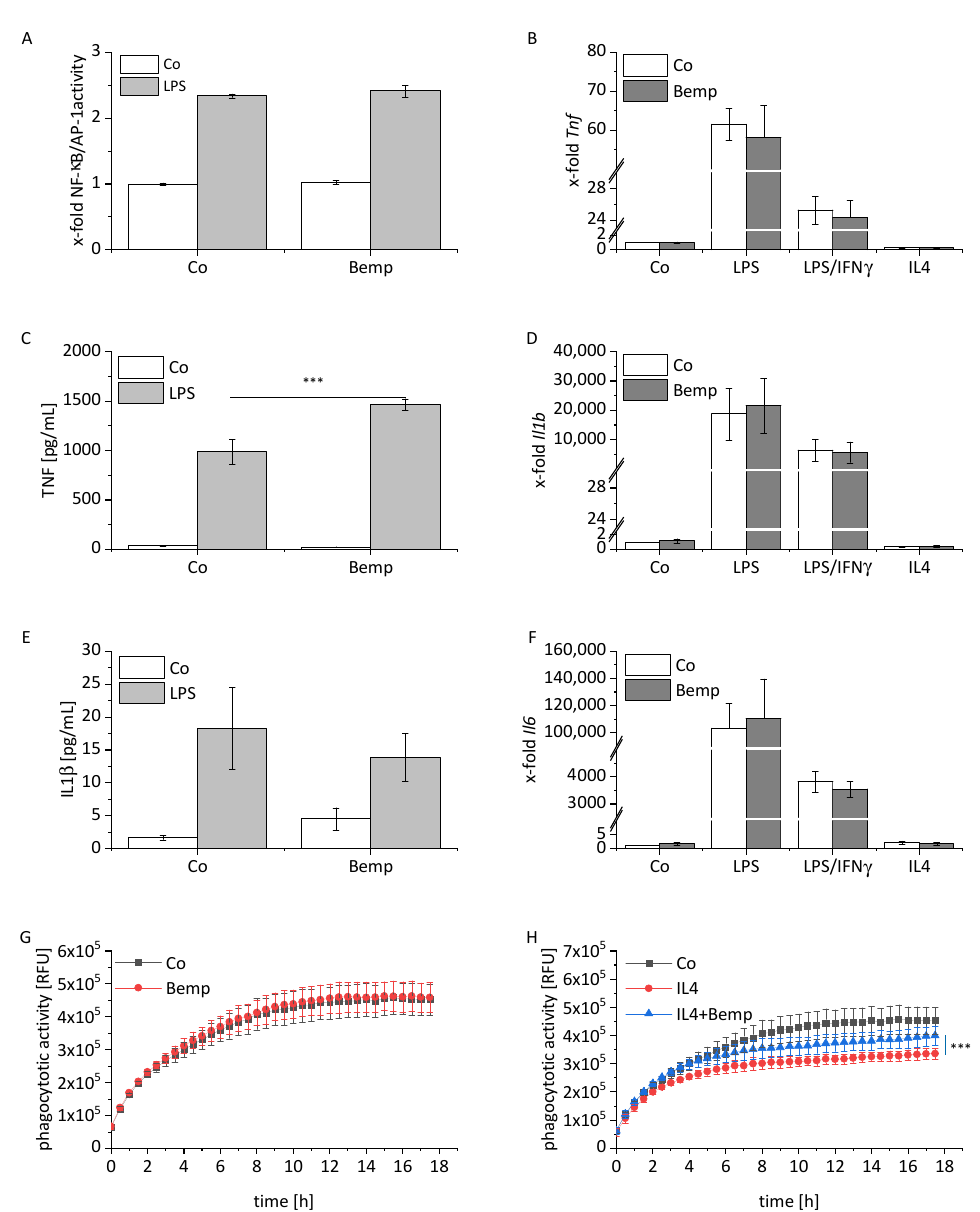
Figure 5. Effect of bempedoic acid treatment macrophages. ( A ) RAW-Blue TM cells were treated with bempedoic acid (Bemp, 25 µM) for 24 h. Inflammatory activation was induced by treatment with LPS (100 ng/mL) for the final 4 h. NF- κ B/AP-1 activity was determined by secreted embryonic alkaline phosphatase (SEAP) detection. Co = solvent control ( n = 3, triplicates). ( B , D , F ) Tnf ( B ), Il1b ( D ), and Il6 ( F ), mRNA expression in BMMs was determined by real-time RT-PCR, normalized to Ppia , and expressed as x-fold of Co. BMMs were stimulated for the last 4 h with LPS (100 ng/mL) or polarized towards M1 (LPS, 100 ng/mL; IFN γ , 20 ng/mL) or M2 (IL4, 20 ng/mL) in the presence or absence of Bemp (25 µM) for 24 h. Co = solvent control ( n = 6). ( C , E ) TNF ( C ) and IL1 β ( E ) were measured by bioassay. BMMs were treated for 24 h with Bemp (25 µM). Inflammatory activation was induced by treatment with LPS (100 ng/mL for IL1 β , 10 ng/mL for TNF) for the final 4 h. Co = solvent control ( n = 3, duplicates for TNF, triplicates for IL1 β ). ( G , H ) BMMs were treated for 24 h with Bemp (25 µM) in the presence or absence of IL4 (20 ng/mL) and monitored by an IncuCyte S3 system after the addition of fluorogenic pHrodo ® Red S. aureus bioparticles (5 µg/well). Quantification of phagocytotic activity expressed as mean red fluorescence intensity normalized to confluence ( n = 4, duplicates). RFU = relative fluorescence units. A one-sample t-test followed by a Bonholm post hoc test was used for analyzing gene expression data of the control group. Means of more than two groups were compared by one-way ANOVA with Bonholm post hoc test (normal distribution). Statistical analysis of phagocytotic activity was performed by two-way ANOVA with Bonholm post hoc test. *** p <